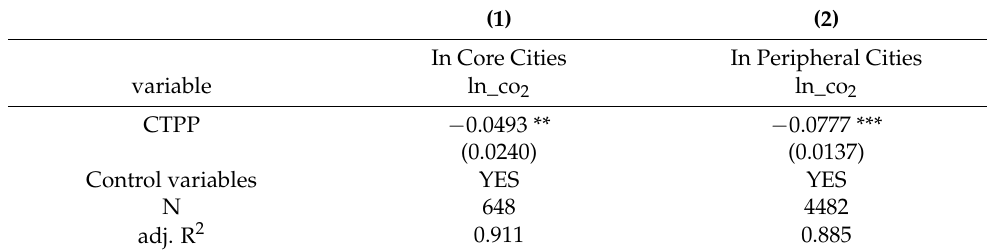
Table 11. Regression results from city